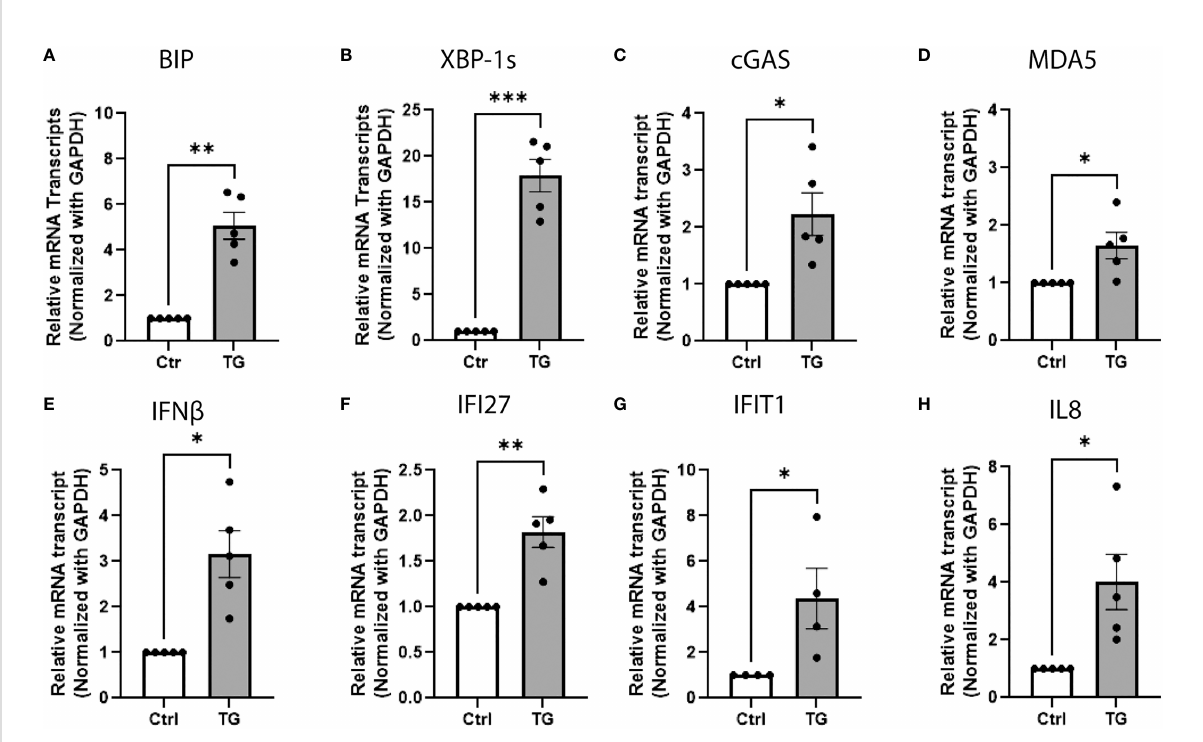
FIGURE 2 ER stress triggers cytosolic nucleic sensors and IFN-I response in beta-cells. QPCR analysis of EndoC- b H1 treated with thapsigargin (TG; 0.1µM, 24h) showing the relative mRNA expression of (A, B) ER stress markers BIP and XBP-1spliced variant, (C, D) cytosolic nucleic acid sensors cGAS and MDA5, (E – G) type 1 interferon responsive genes IFN b , IFIT27, IFIT1 and (H) chemokine IL8. Data are presented as mean ± SEM (n = 5) and statistically analyzed by student ’ s t-test. Signi fi cance is indicated by *P < 0.05, **P < 0.01, and ***P <